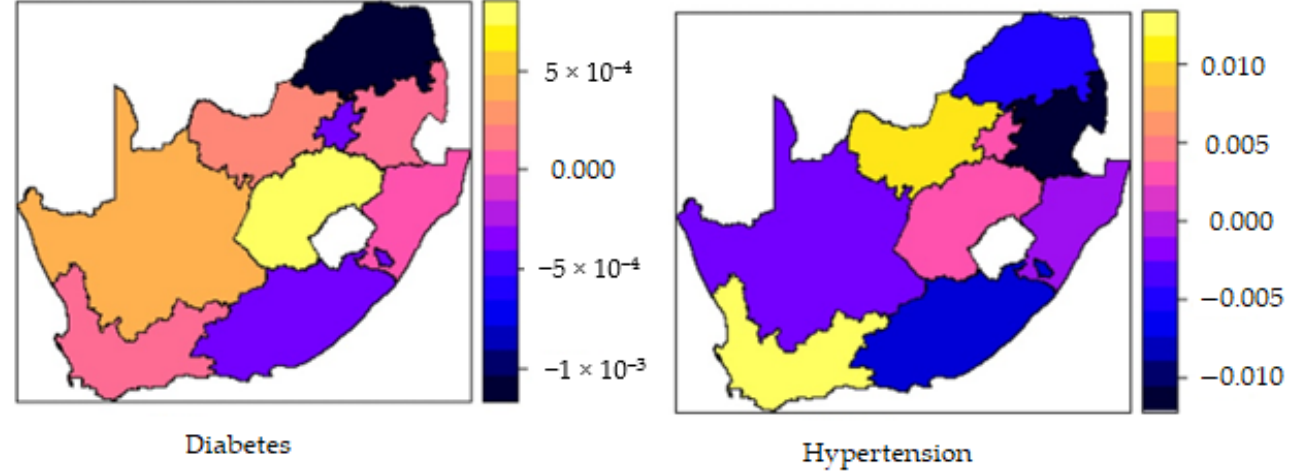
Figure 4. Map of South Africa showing posterior means of spatial effects of diabetes and hyperten- sion.